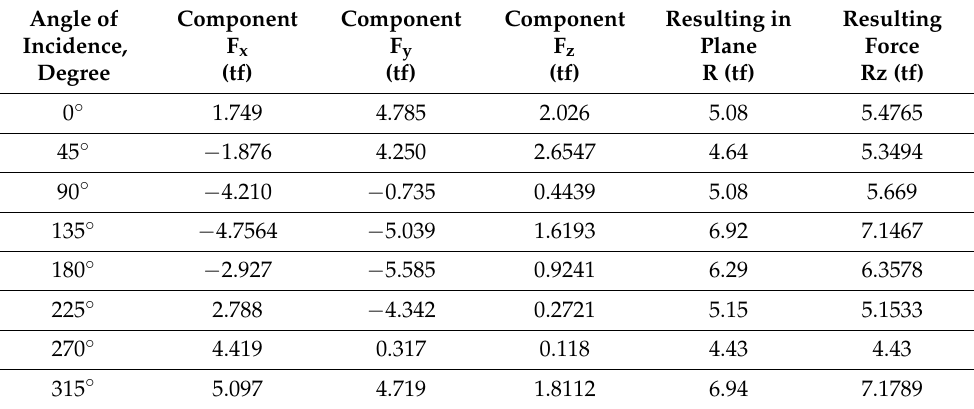
Table 3. Distribution of forces of Fx, Fy, and Fz (tf) and their resulting vector R (tf) in the XOY plane and in the Rz (tf) space for the open aeroelastic model, Option (0000). Angle